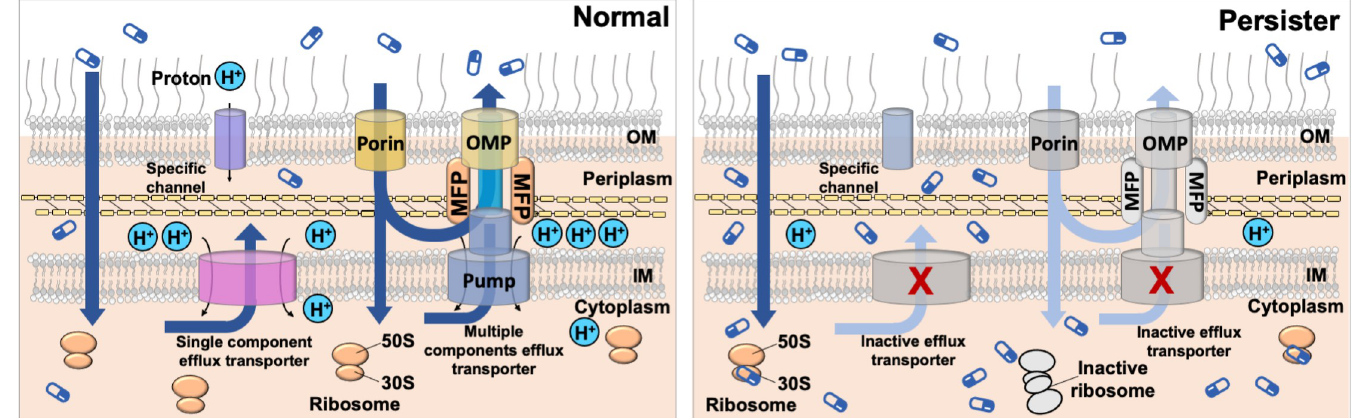
Fig 6. A conceptual model of persister control by leveraging reduced antibiotic efflux. Persisters have reduced membrane potential and thus are difficult to penetrate by hydrophilic antibiotics and those require active transport. In comparison, antibiotics that can penetrate through lipid without active uptake can still target persister cells. Additionally, reduced drug efflux provides a favorable condition for accumulation of antibiotics in persister cells. This leads to killing if the internalized antibiotic molecules remain bound to the target during wake-up. The inactivated pathways in persister cells are indicated with lighter colors and/or marked with “X”. Minocycline, rifamycin SV, and eravacycline fit the criteria and are found effective in this study for persister control. The drugs targeting the 30S ribosomal subunit demonstrated in this study are shown as an example. Figures are drawn for Gram-negative species as tested in this study.